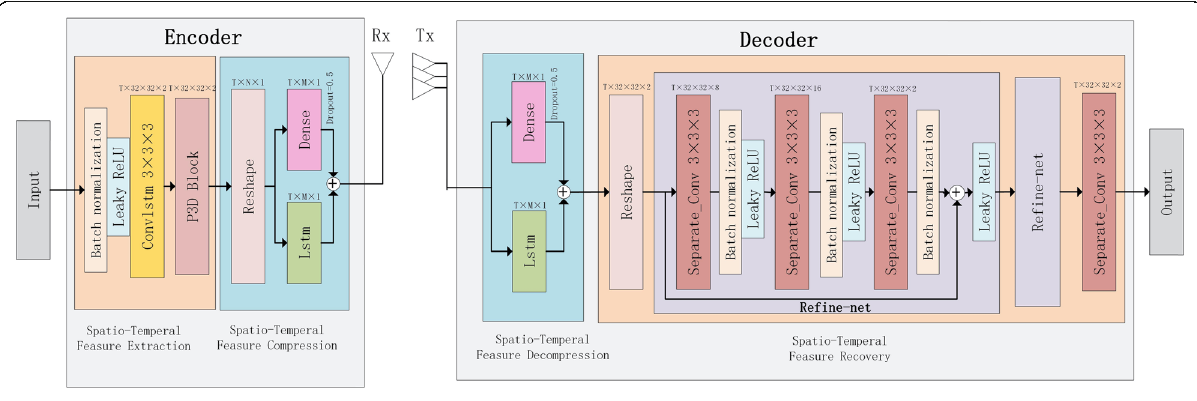
Fig. 3 The architecture of ConvlstmCsiNet with P3D block